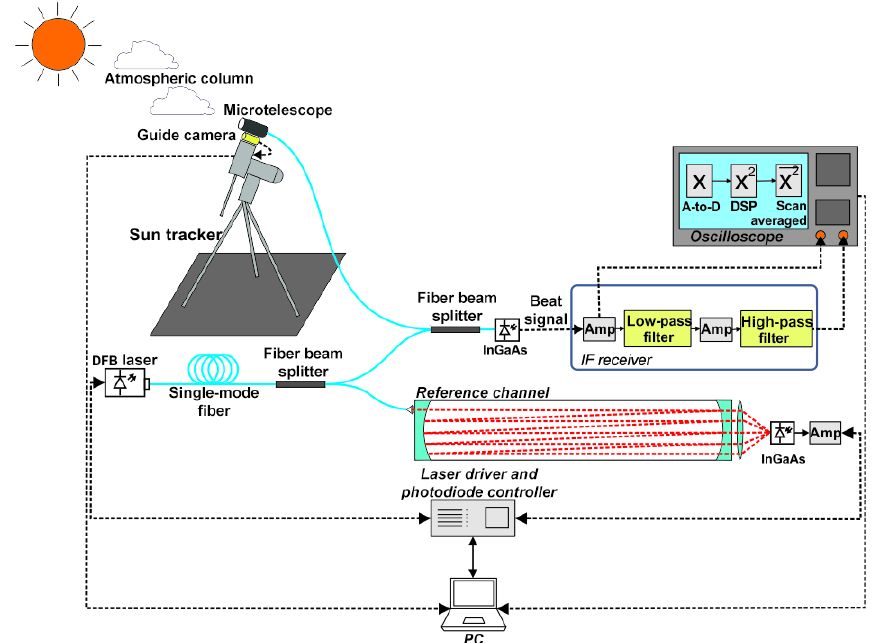
Figure 1. The sketch of a laser heterodyne spectrometer used for wind profiling.